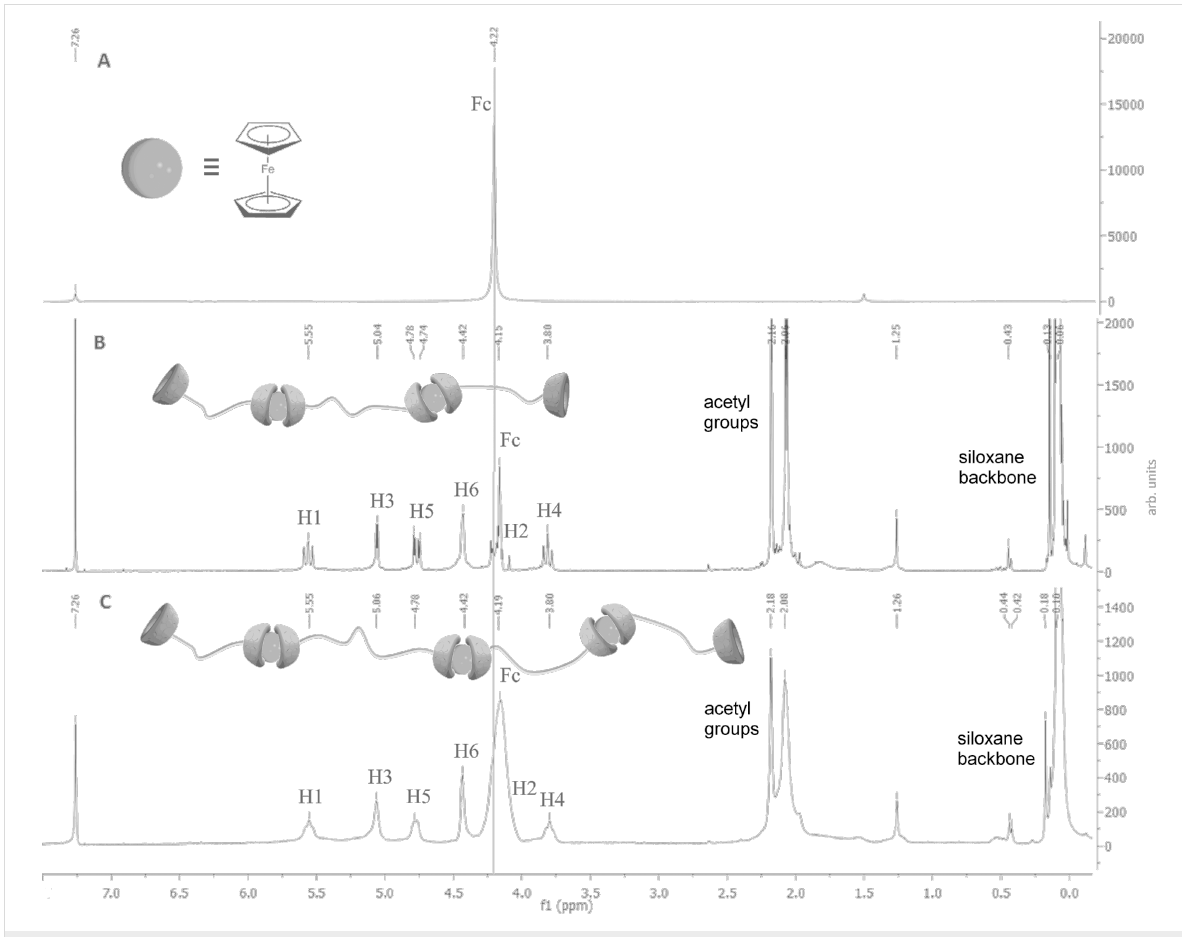
substituents appear in the area of 3.50 to 6.00 ppm. New peaks at 0.43 and 1.25 ppm of the resulting dimethylene bridge between the siloxane and α -CD are detectable. Signals for the double bond of the vinyl group and the Si–H bond of the starting materials are absent, as expected. The MALDI–TOF spectra of the modified poly(dimethylsiloxanes) 4 and 5 show terminally substituted products of various chain lengths, wherein the distance of 74 g/mol between the mass signals exactly corresponds to one dimethylsiloxane unit. The results of the IR, 1 H NMR and mass spectroscopy strongly support the existence of the described derivatives. The terminally α -CD- functionalized poly(dimethylsiloxanes) 4 and 5 were subse- quently used as host molecules component for the following complexation